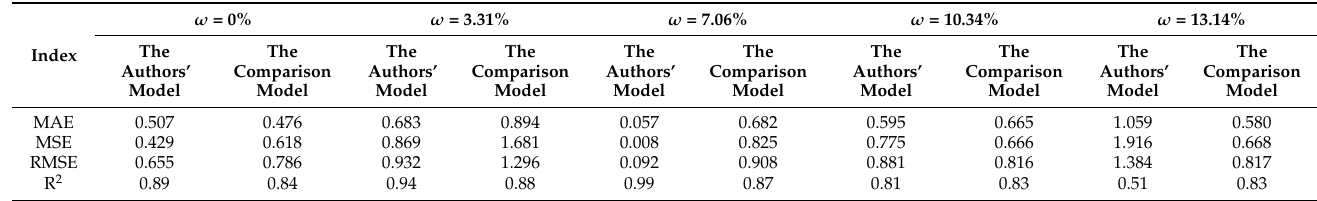
Table 2. The fitting effect evaluation index values of the two models based on the experimental data in test group 1.